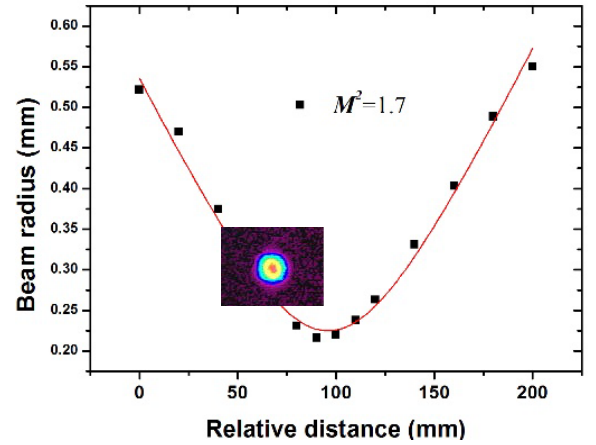
Figure 8. The far field beam profile and the result of M 2 measurement. (Inset: typical two-dimensional beam profiles).